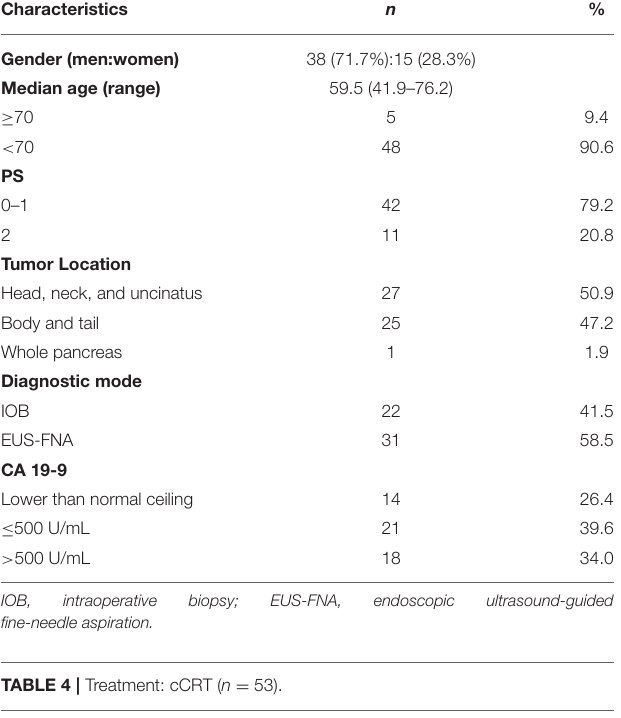
TABLE 3 | Patients’ characteristics of cCRT ( n = 53).